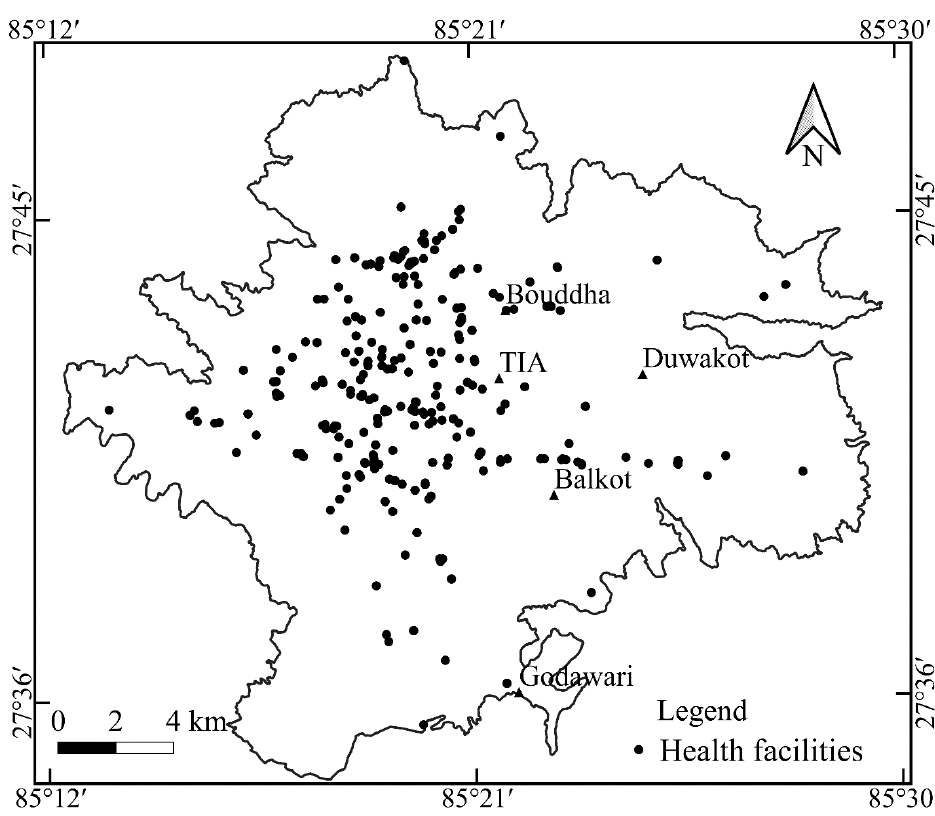
Figure 6. Health facilities in Kathmandu Valley.